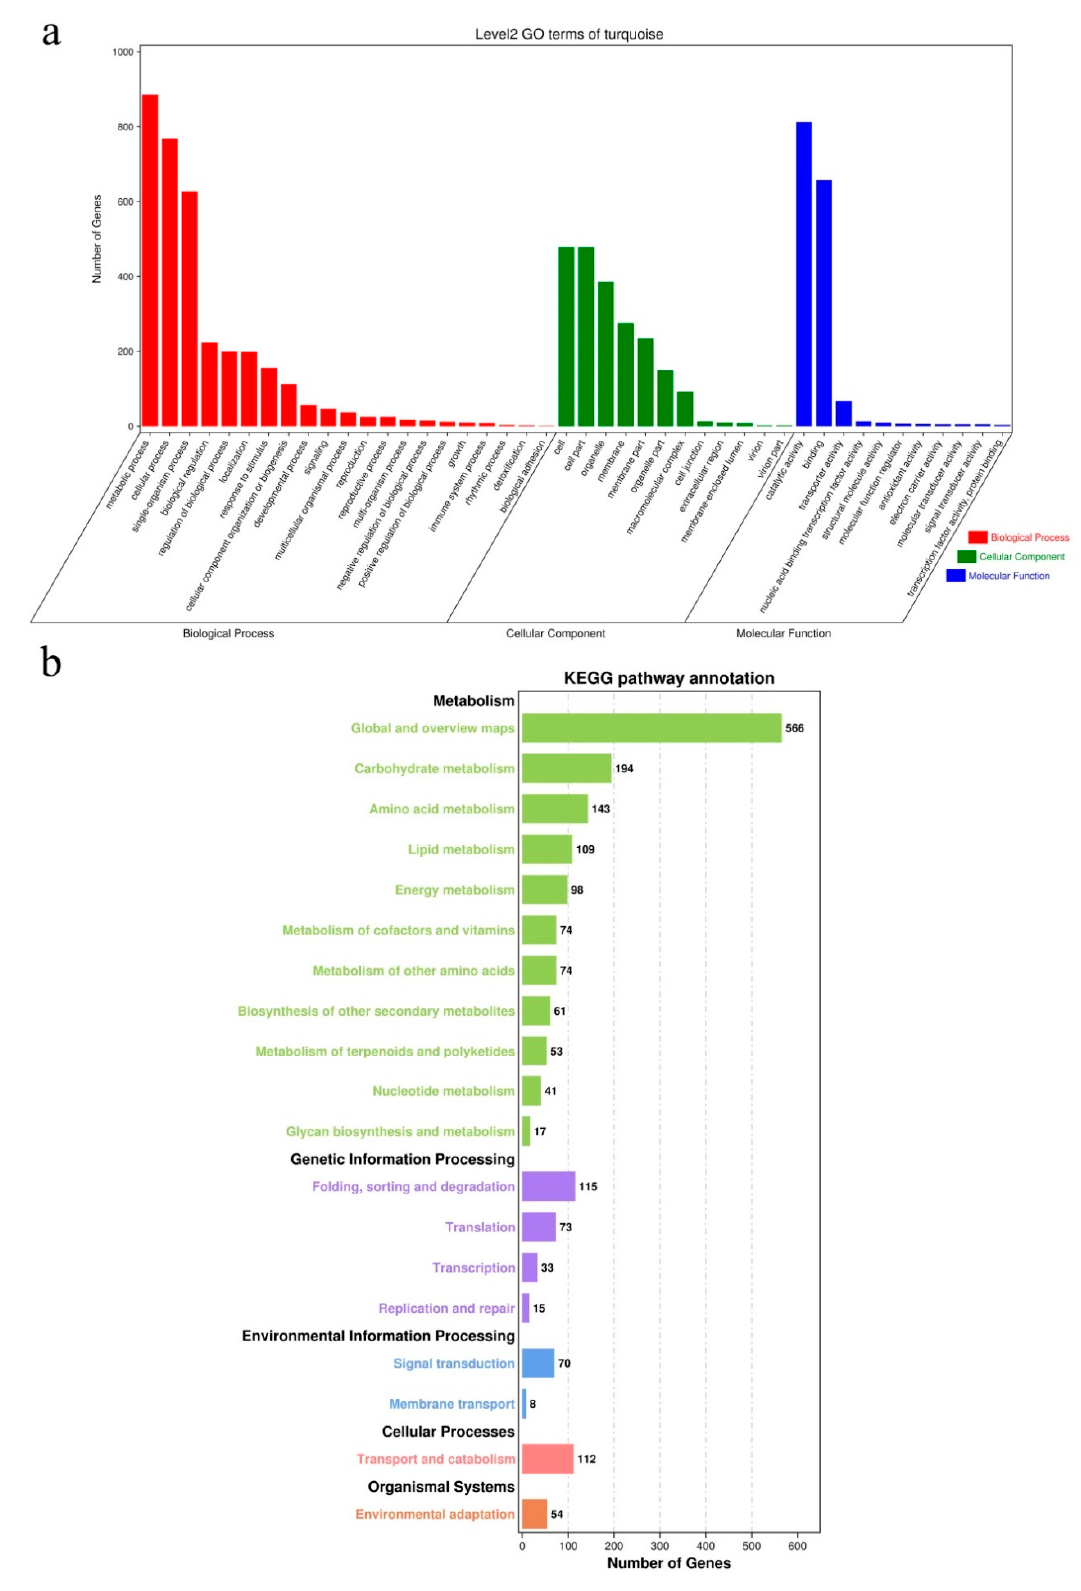
Figure 10. Function enrichment analysis of module turquoise gene. ( a ) Gene Ontology (GO) enrichment of module turquoise gene. ( b ) KEGG pathway enrichment of module turquoise gene.